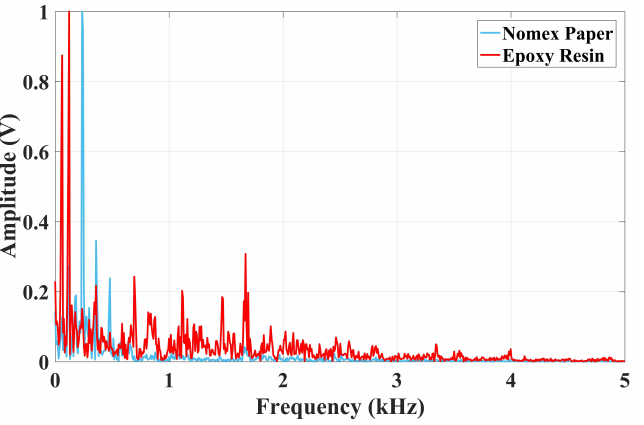
Figure 5. Frequency content of PD activity in epoxy resin and Nomex paper for piezoelectric